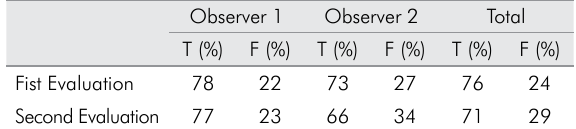
Table 3. Percentage of True (T) and False (F) diagnosis of oroantral communication caused by periapical lesions.